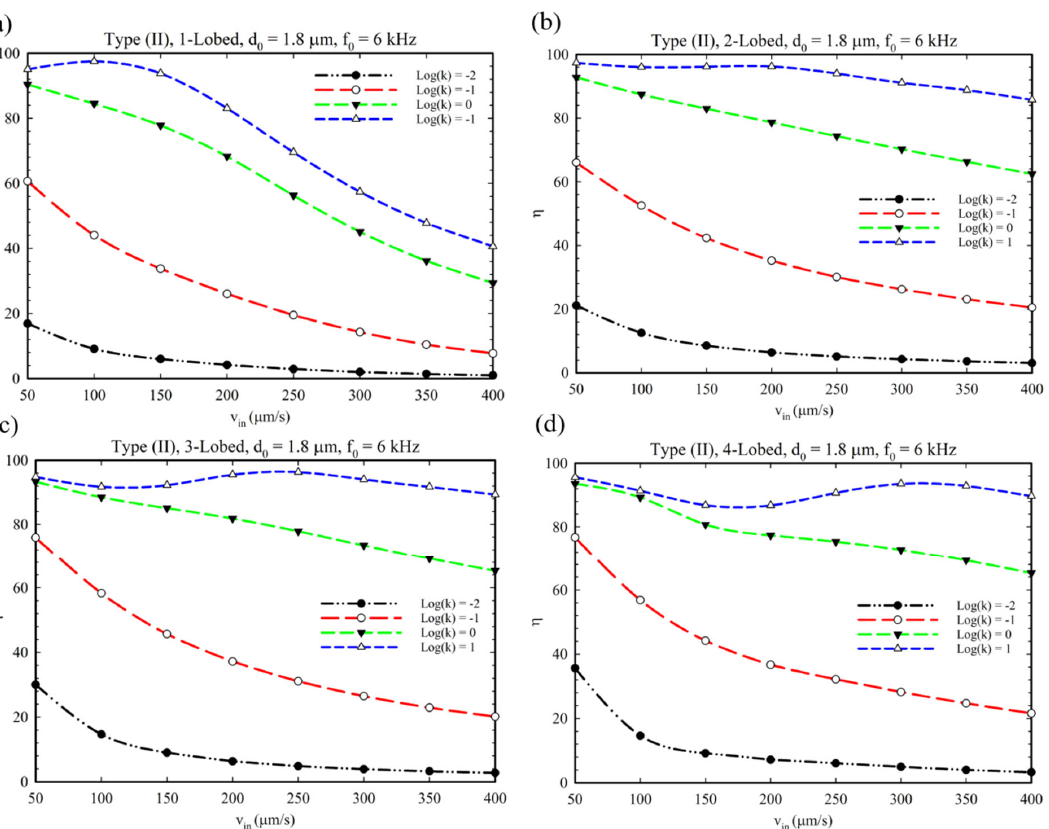
Figure 11. Production efficiency at different fluid velocities for type (II) microchannels with the geometries of ( a ) 1 ‐ lobed, ( b ) 2 ‐ lobed, ( c ) 3 ‐ lobed, and ( d ) 4 ‐ lobed structures.